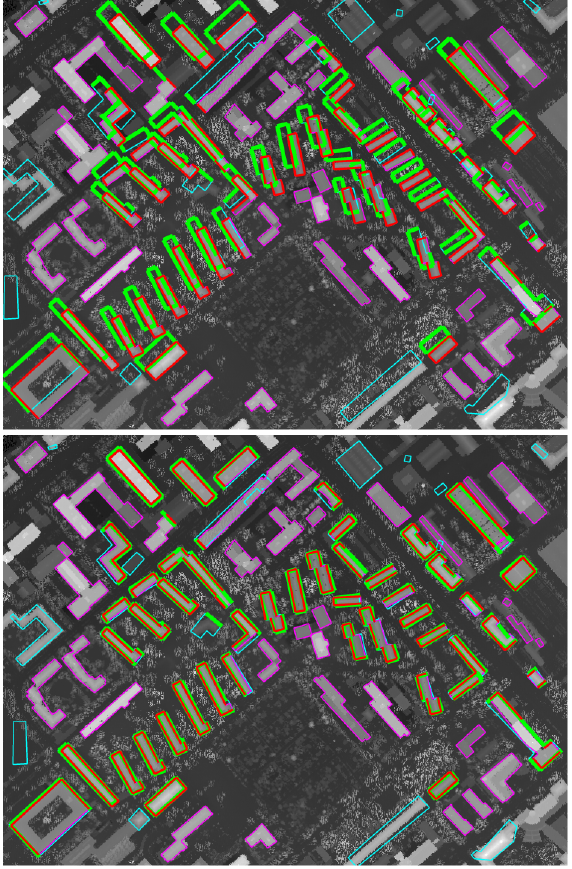
Figure 3: Detected buildings in LiDAR DSM and HSI, before (top) and after coregistration (bottom). Red: lines detected in LiDAR data matched with lines detected in HSI. Cyan: lines de- tected in HSI without any matches found in DSM. Magenta: lines detected in LiDAR DSM without any matches found in HSI .